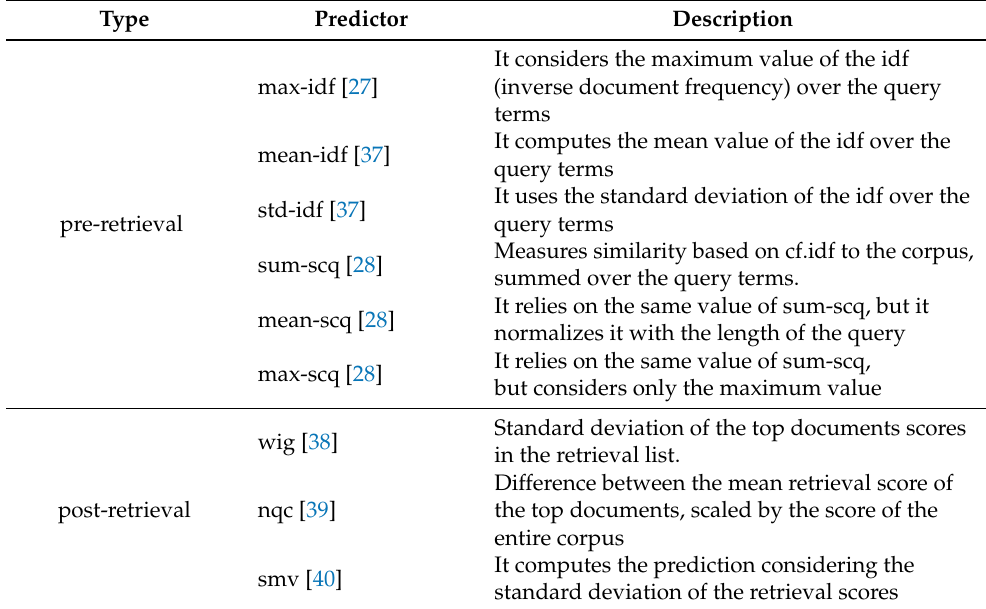
Table 1. Pre- and Post-retrieval predictive baseline models